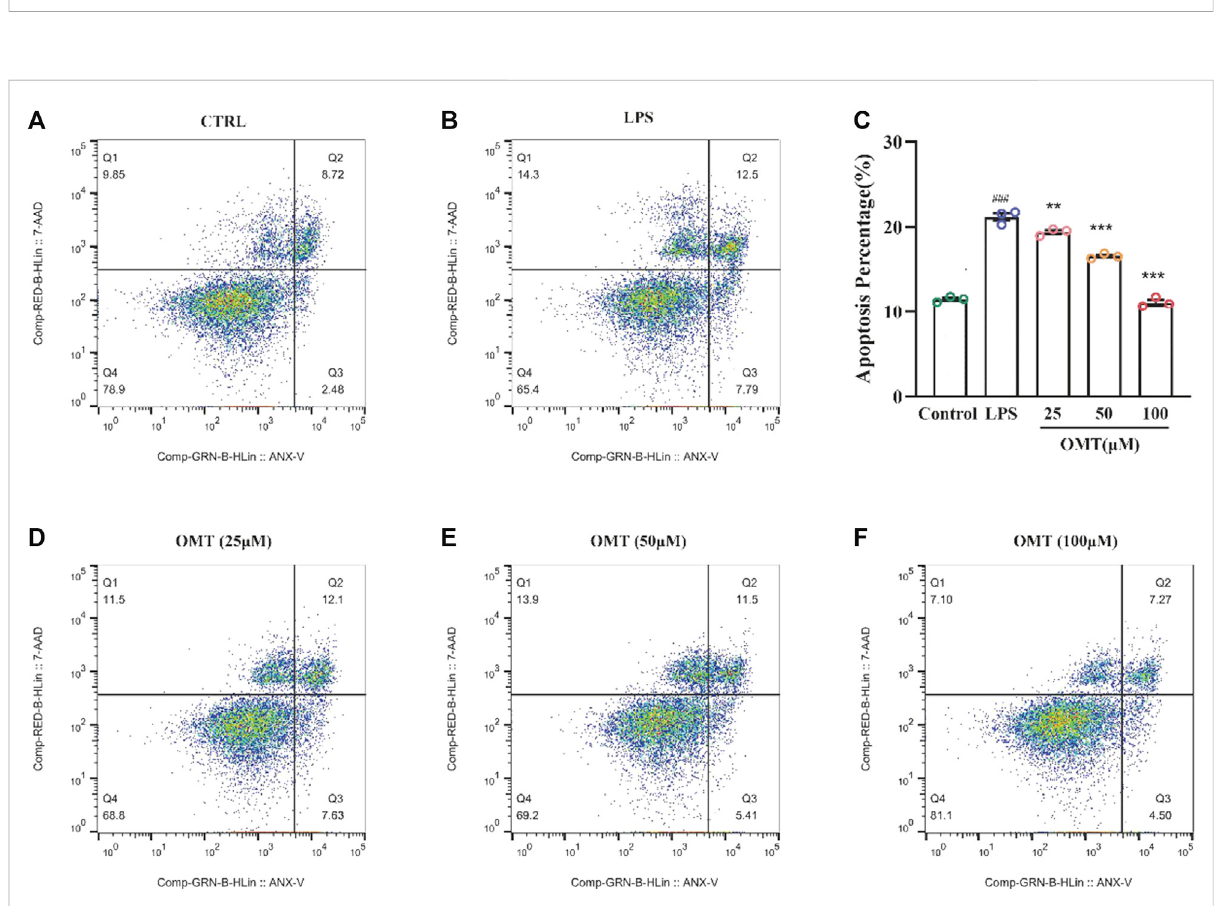
FIGURE 10 Effects of OMT on the apoptosis of LPS-induccd RAW264.7 cell in fl ammation model detected by fl ow cytometry and the histogram of apoptosisrateofcells. (A) Raw264.7cells(control):livecells:78.9%,necrotic:9.85%,earlyapoptosis:2.48%,lateapoptosis:8.72% (B) RAW264.7cell+ LPS: live cells: 65.4%, necrotic: 14.3%, early apoptosis: 7.79%, late apoptosis: 12.5% (C) RAW264.7 cells + OMT (25 iM): live cells: 68.8%, necrotic: 11.5%, early apoptosis: 7.63%, late apoptosis: 12.1%. (D) RAW264.7 cells+ OMT (50 iM): live cells: 69.2%, necrotic: 13.9%, early apoptosis: 5.41%, late apoptosis: 4.50% (E) RAW264.7 cells + OMT (100 iM): live cells: 81.1%, necrotic: 7.10%, early apoptosis: 4.50%, late apoptosis: 7.27%. Values represent average± S.D.Signi fi cantdifferencesamongdifferentgroupsareindicated as ### p < 0.001 vs.control; * p < 0.05, ** p < 0.01,*** p < 0.001vs. LPS